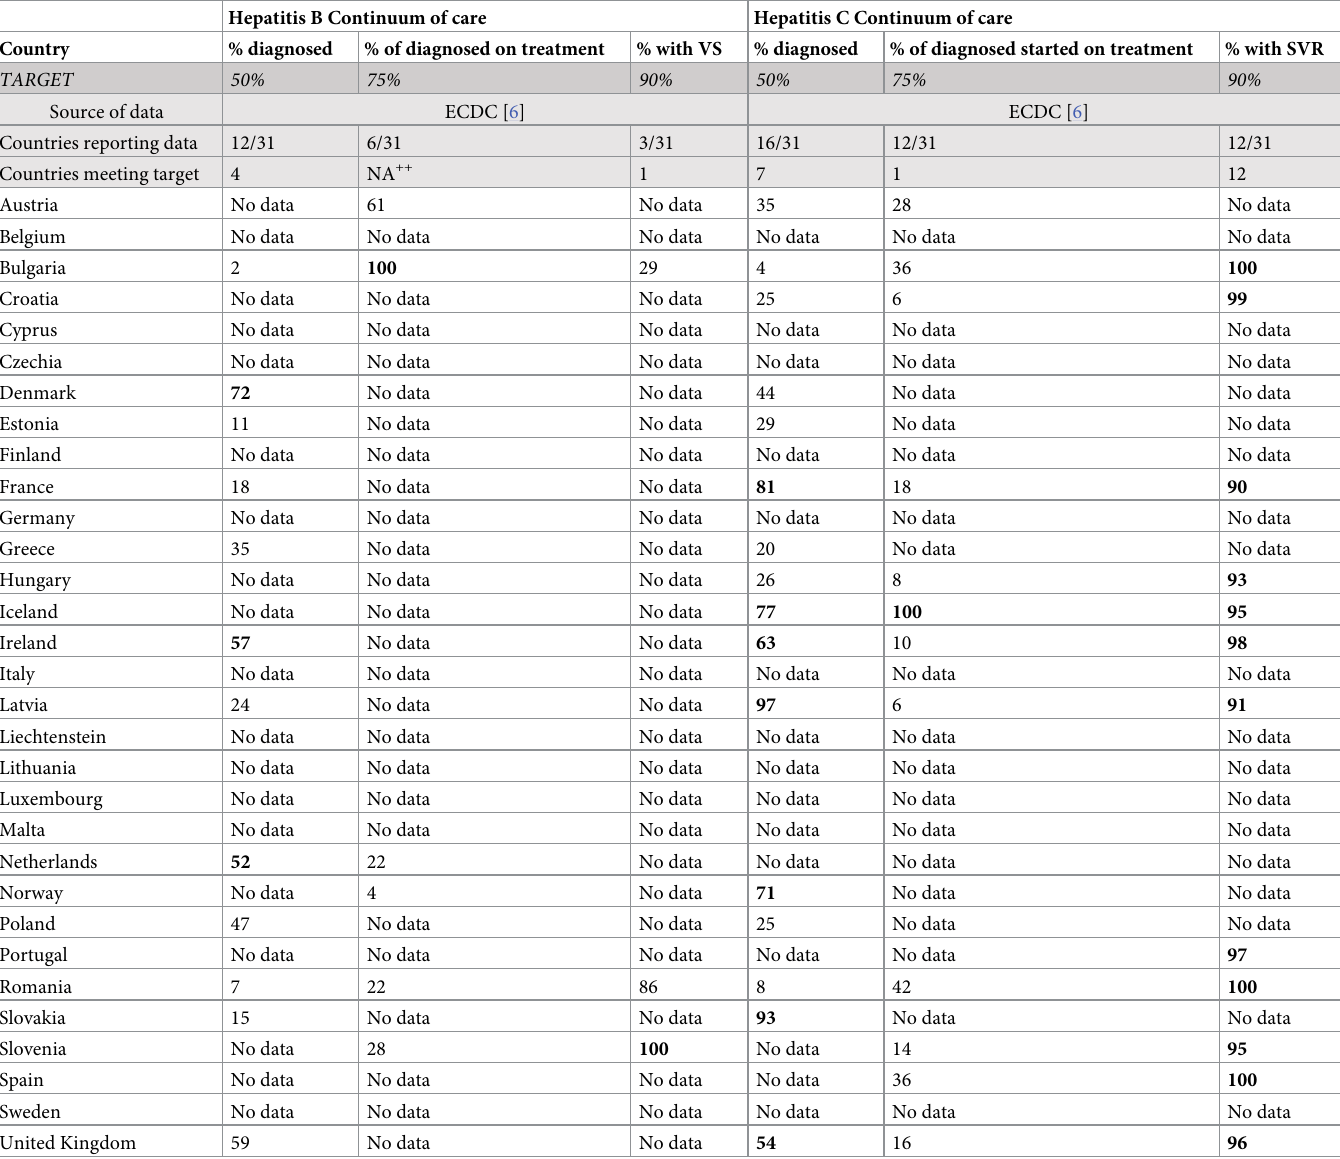
Table 3. Region and country reporting and progress towards targets for the hepatitis continuum of care in the EU/EEA and UK, 2017¥ [8] + . Hepatitis B Continuum of care Hepatitis C Continuum of